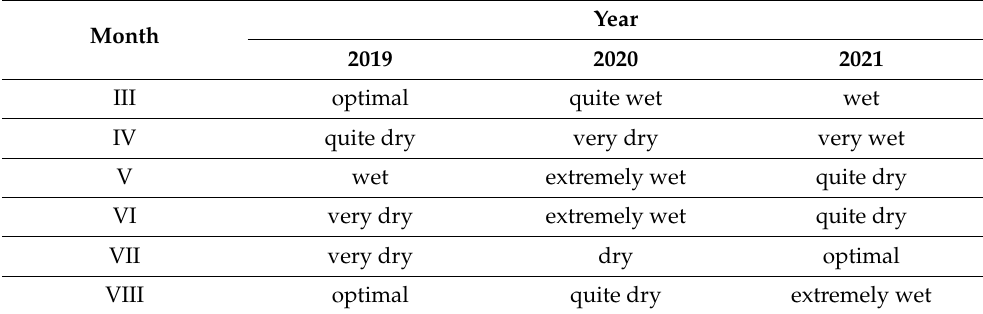
Table 5. Values of the Selyaninov hydrothermal index (k) in each growing season (2019–2021).